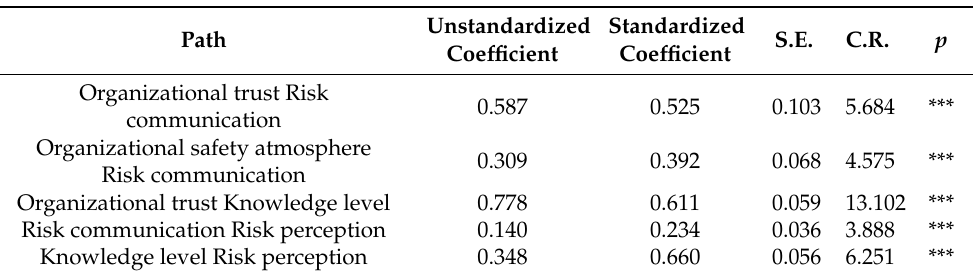
Table 8. Path indicators of model